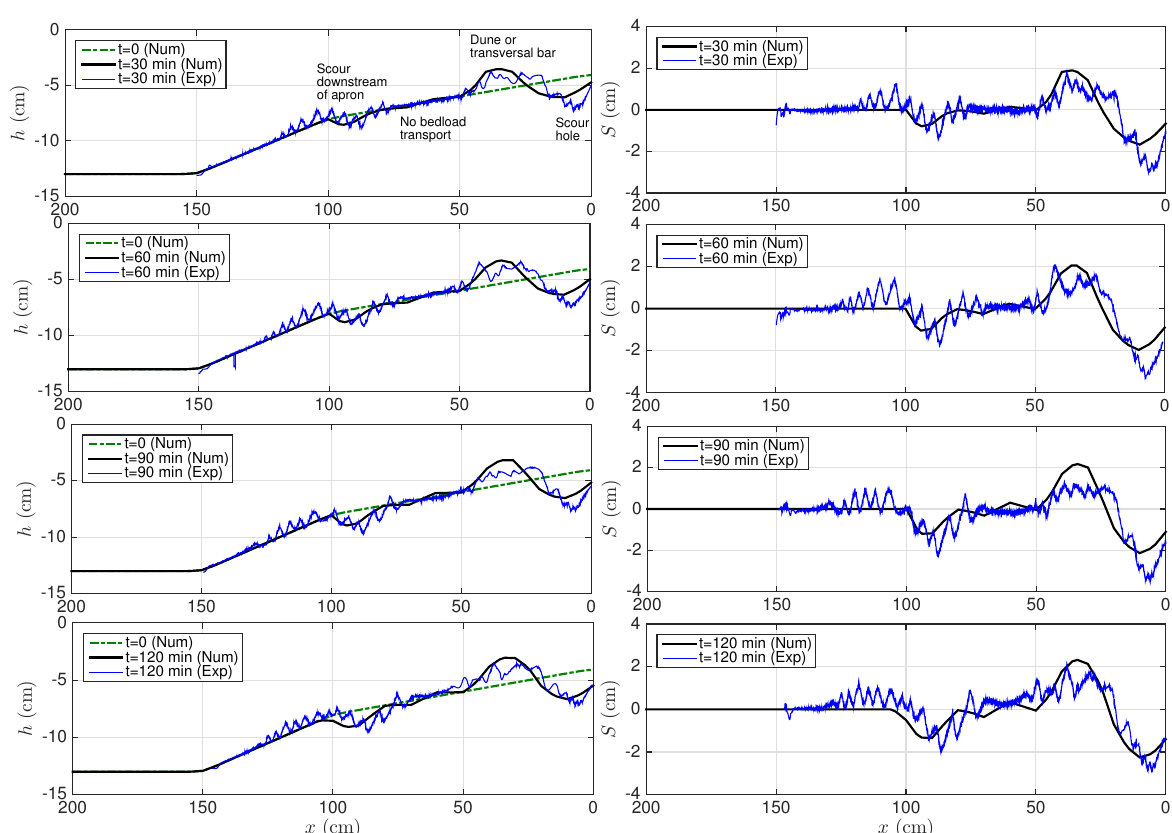
Figure 14. Numerical and experimental results (at y = 0.15 m) of the scour depth for Test